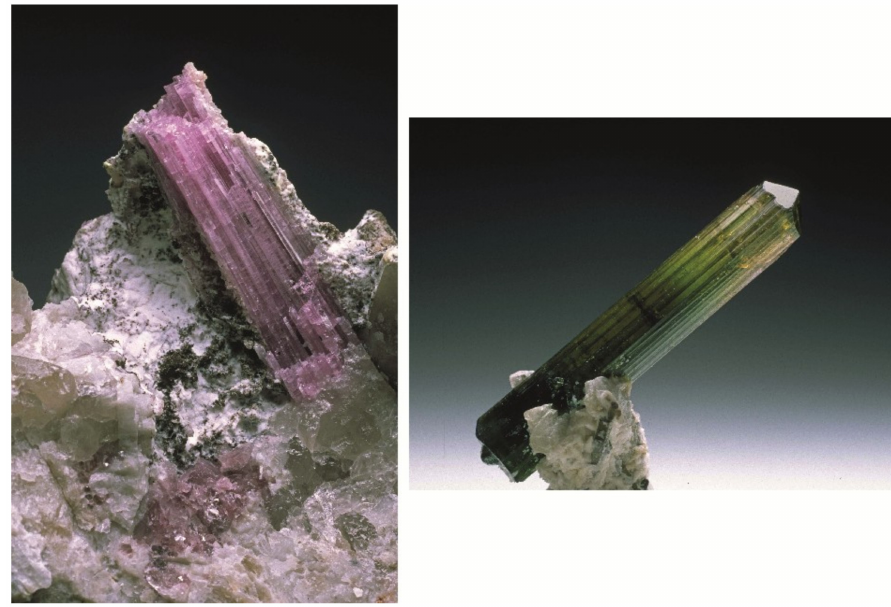
Figure 1. Crystals of pink (3.5 cm long) and green (5 cm long) tourmalines from Valle Adam é , Adamello Massif. Natural History Museum of Milan collection. Photos by R.